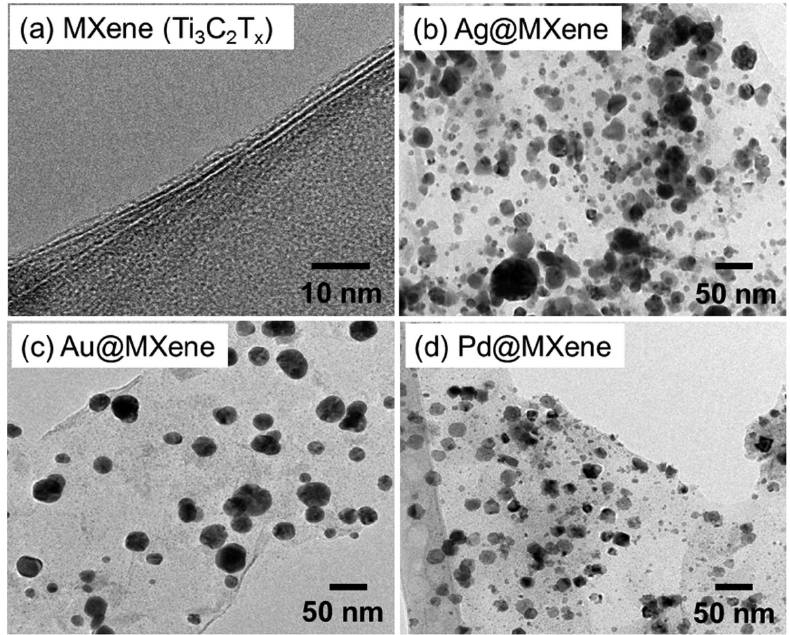
Figure 14. ( a ) High-resolution TEM image of MXene nanosheets and low-resolution TEM images of ( b ) Ag@MXene, ( c ) Au@MXene and ( d ) Pd@MXene hybrid nanosheets. Reprinted with permission from [70]. Copyright 2016 Springer Nature.